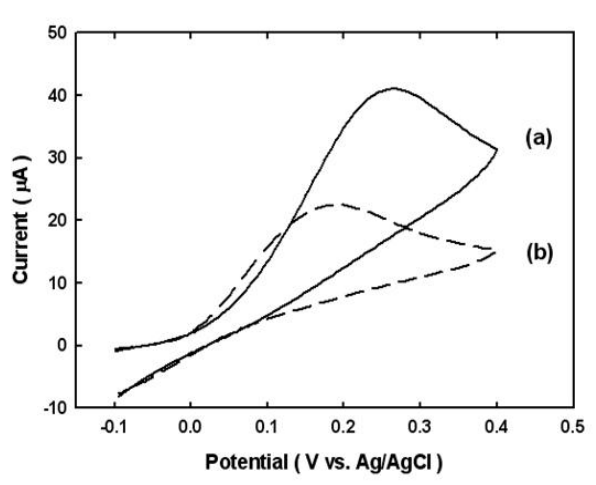
Figure 4. Comparison of CV data on (a) Au@Nb All CV were obtained after incubating for 1 minute in EB containing 1 mM APP and at a scan rate of 20 mV s − 1 . The concentration of mouse IgG is 100 μ g mL –1